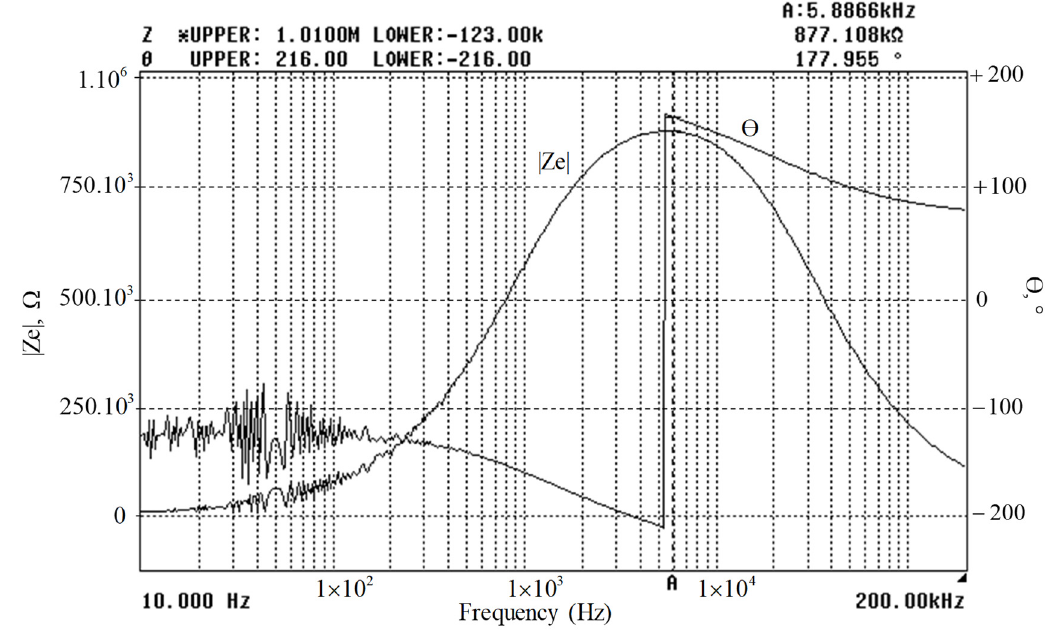
Figure 9. Impedance Z and phase angle θ against frequency for a sample PET/Ag/BST:PVDF-TrFE/Ag.